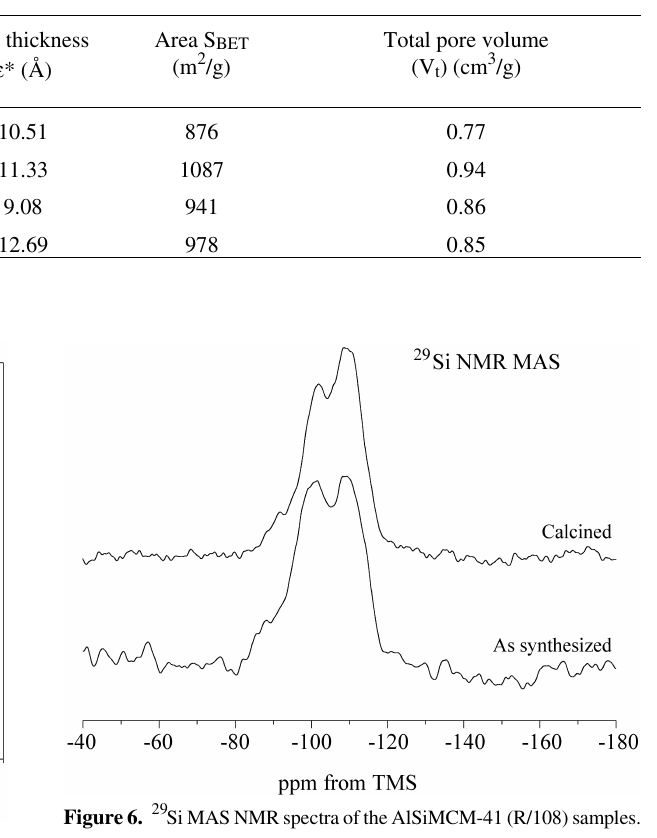
Figure 4. XRD of the as synthesized SiMCM-41(P/Y)